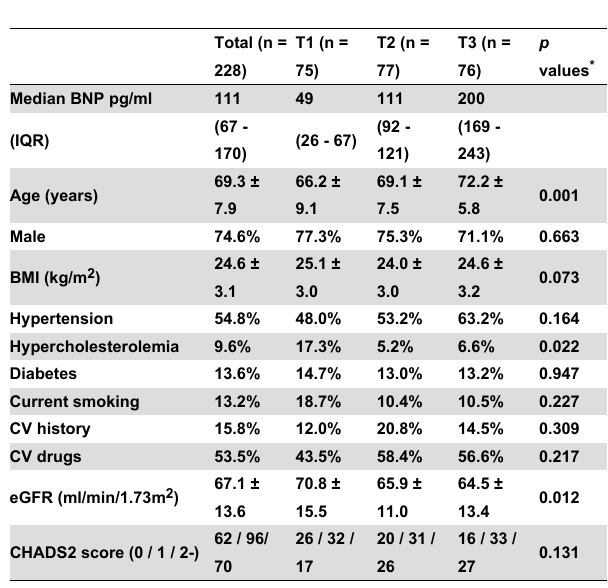
Table 1. Clinical characteristics of subjects with AF among tertile of plasma BNP